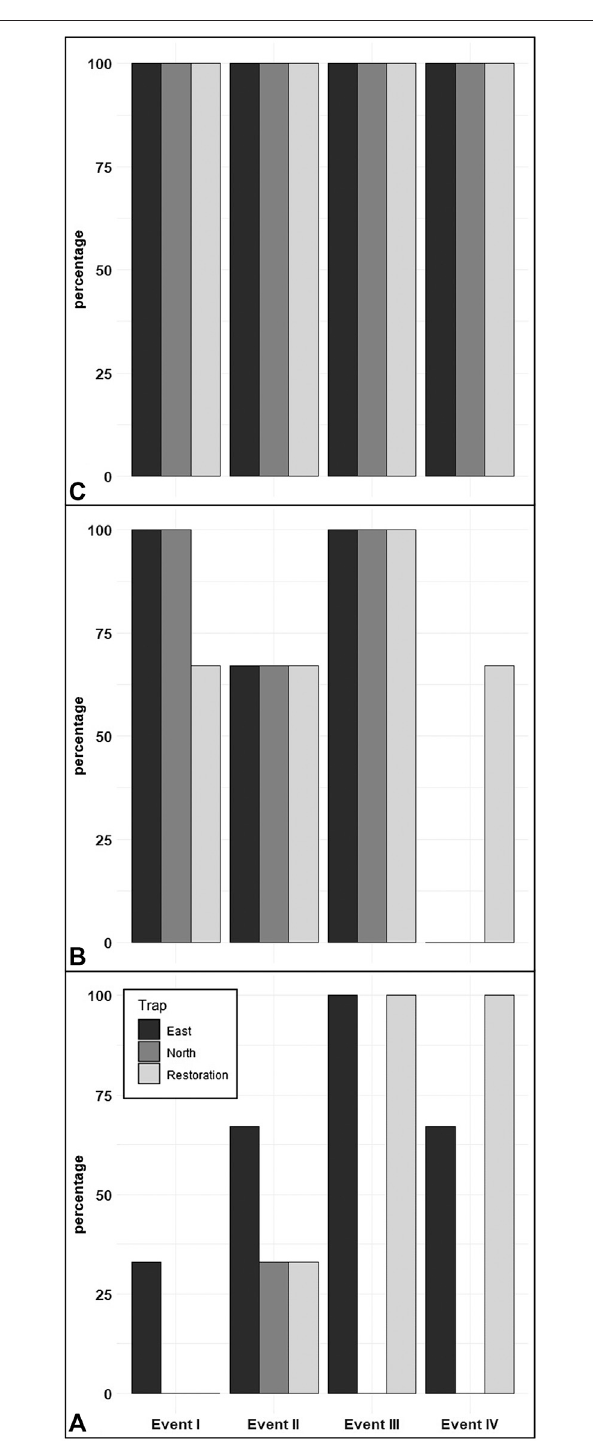
FIGURE 6 | The global plant eDNA collected for all three trap locations for all four sampling Events. The global plant eDNA is measured as cycle thresholds (C T ) where decreasing values indicate more eDNA. Global plant eDNA increased in response to restoration activity.